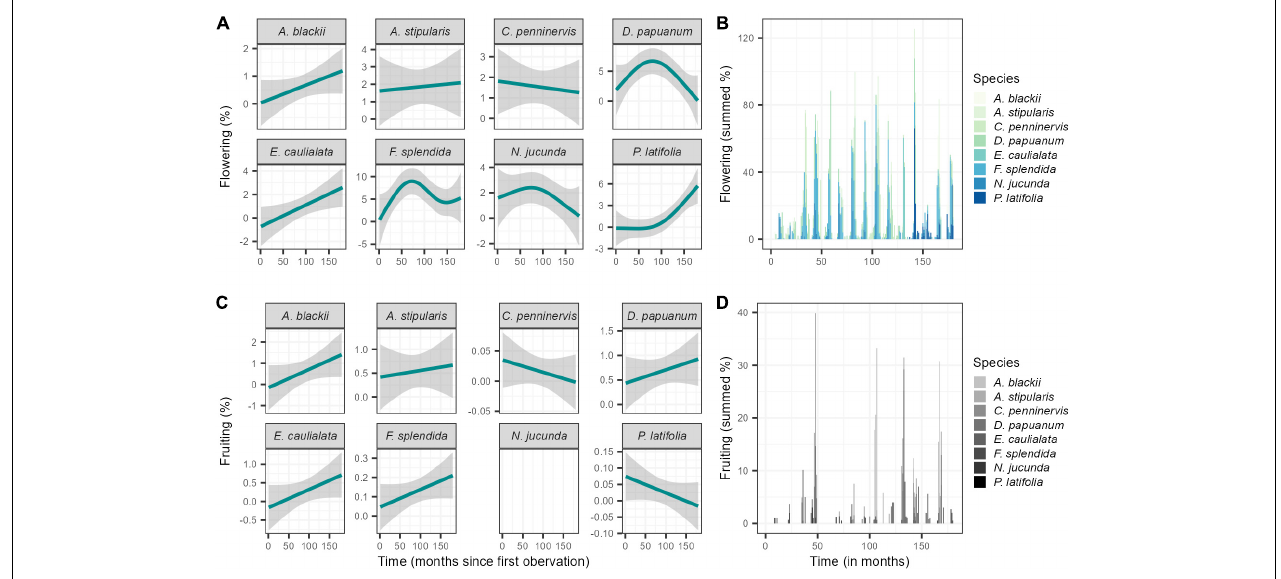
FIGURE 5 | (A) Fitted GAM-smoother for monthly mean percentage of overall flowering and fruiting trends for each of the dominant species and (B) Summed monthly mean activity of flowering and fruiting for the dominant species in Barron Gorge National Park, Far North Queensland,